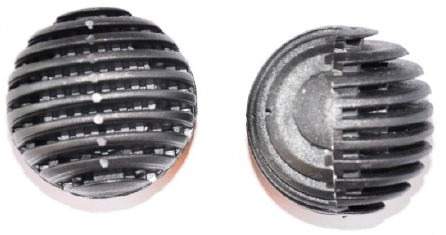
Figure 3. Filling of the US (with anaerobic biofilm).